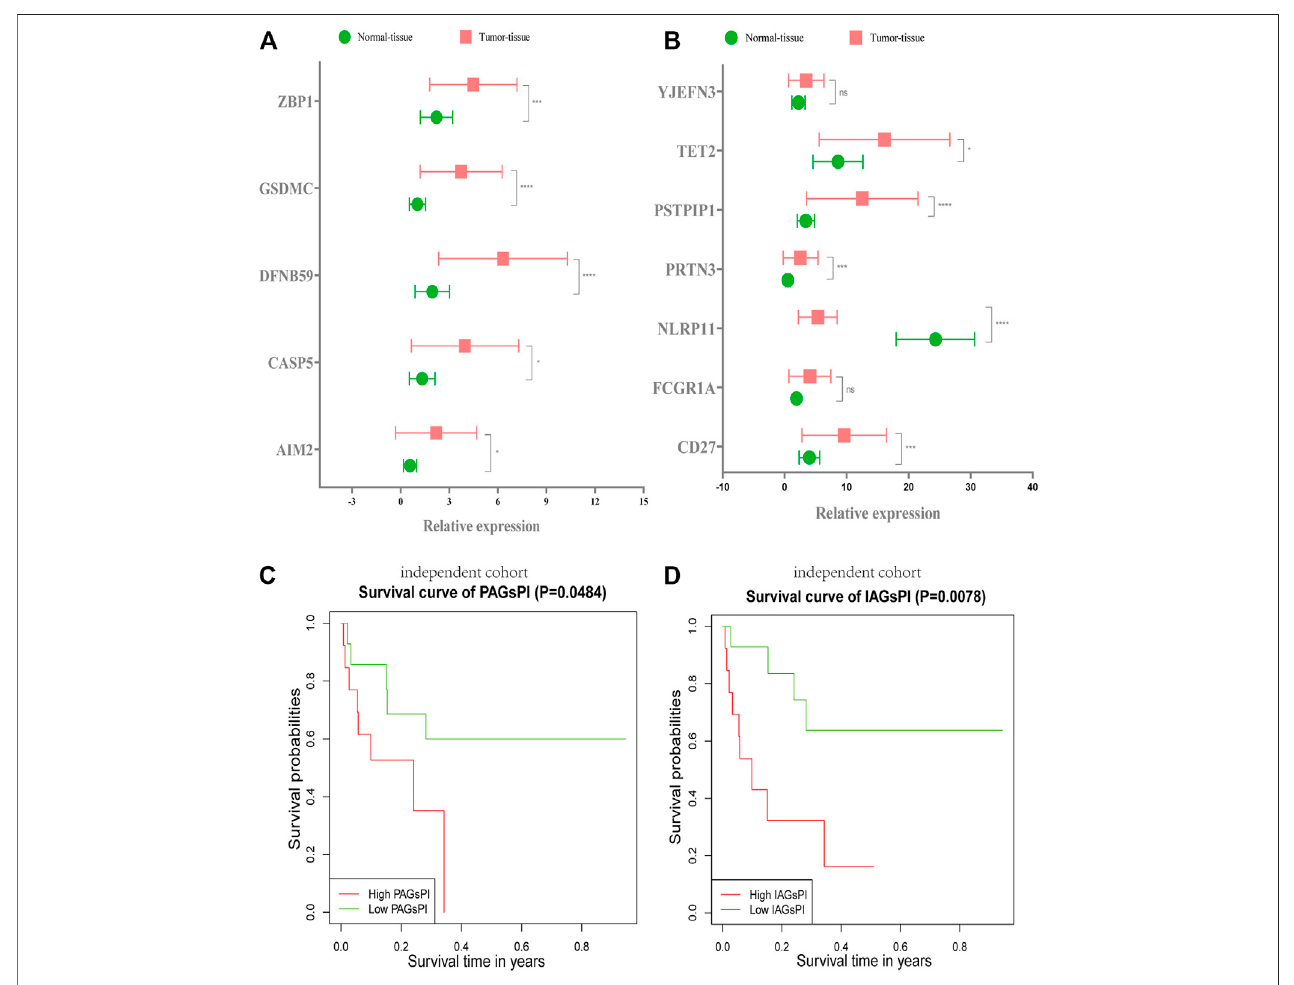
FIGURE9| ValidationofPAGsPIand IAGsPIintheindependent cohort. (A,B) Theexpression levelof5crucialPAGsand7keyIAGsinthenormaland KIRCtumor tissues.The datawereshown asthemeans ±SD. * p < 0.05, ** p < 0.01, and *** p < 0.001. (C,D) In theindependentcohort, KM survival analysisforPAGsPIand IAGsPI.